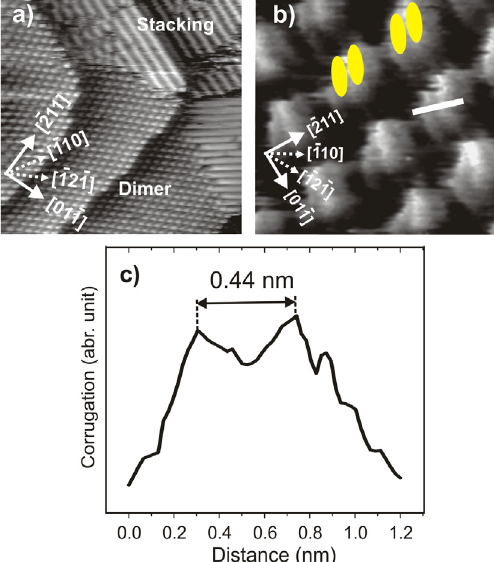
Figure 6. In situ STM images showing the co-existence of dimer phase and alternating stripe phase on the Cl/Cu(111) surface: ( a ) 46.67 nm × 46.67 nm, U = 0.2 nA, E = − 310 mV; ( b ) Atomically resolved STM images of the dimer phase: I t = 355 mV, I = 0.1 nA, E = − 295 mV; ( c ) Line profile recorded along 5.63 nm × 5.63 nm, U b t the white line in panel b indicating an intermolecular distance within a dimer of 0.44